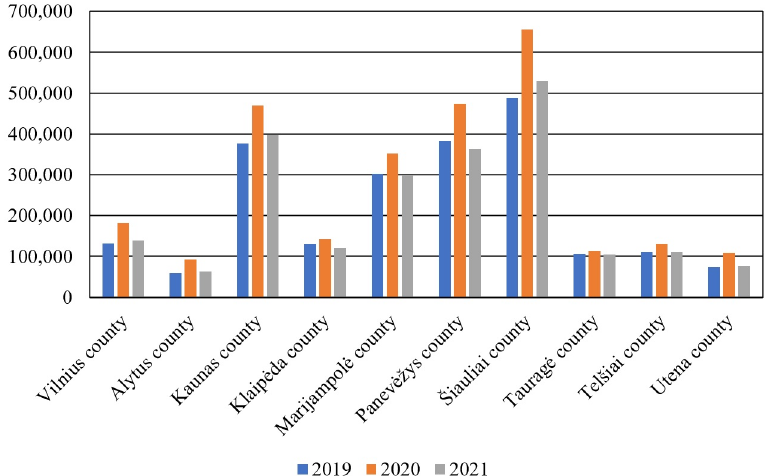
Figure 3. The potential of crop production by-products used for conversion in the counties (t.).